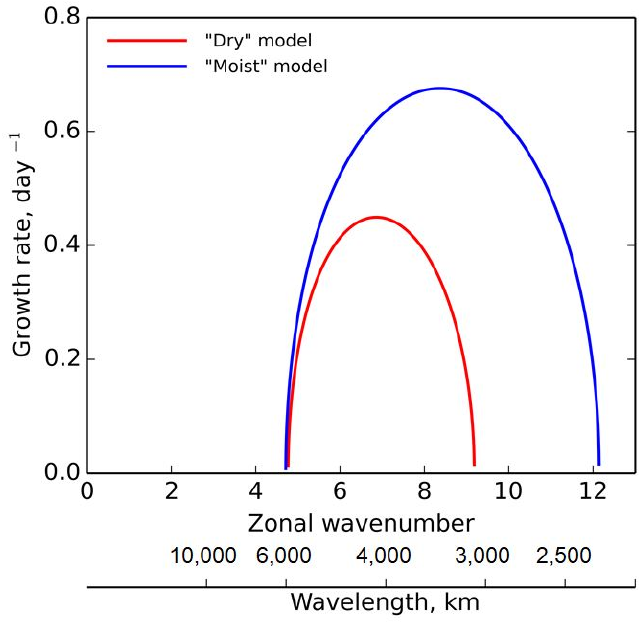
Figure 1. Increments of unstable baroclinic waves for “dry” and “moist” 𝛽 − plane models. Since climate change affects both static stability and MTG [67], we calculated, for reference, the increments of unstable waves for different values of the parameters 𝜎 (cid:2868) and 𝑢 (cid:3021) . Figure 2 illustrates the results obtained using the “dry” model.